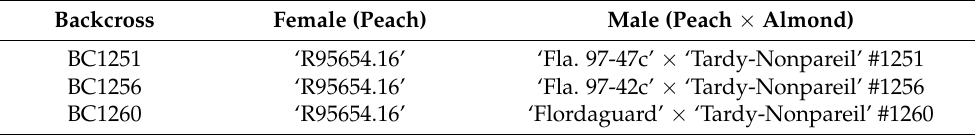
Table 1. Interspecific peach × (peach × almond) backcross populations from which the leafy softwood cuttings were